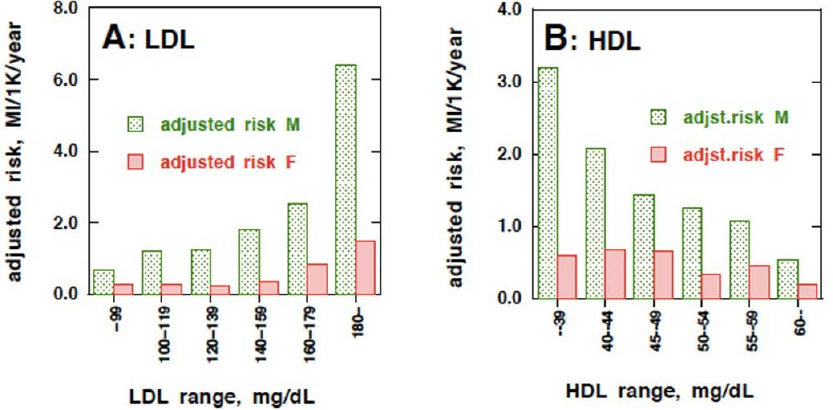
Figure 3. Age-adjusted risk of myocardial infarction (MI) dependent of plasma lipoprotein-cholesterol for each sex. The risk is expressed as events per 1000 population per year (MI/1K/1Y) in J-LIT trial